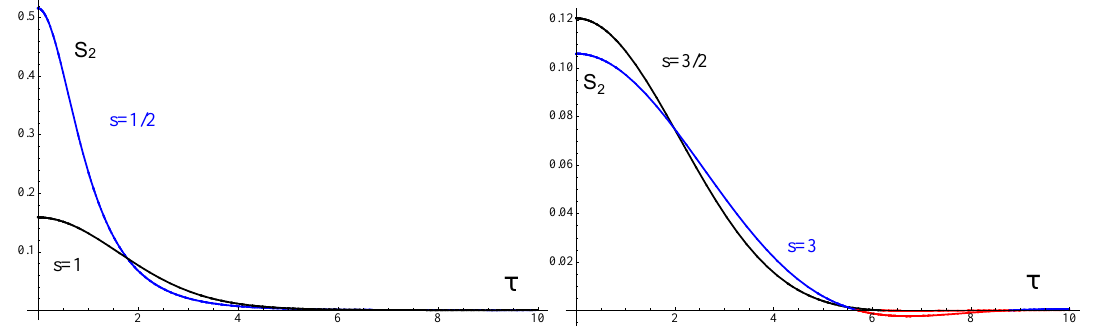
Figure 1. Euclidean time ( τ ) dependence of the (time-reflected) 2-point Schwinger functions S 2 ( − τ , x ; τ , x ) for a non-local scalar field theory with higher derivatives given by Equation (1). For values of s > 1 the S 2 function always reaches negative values for some Euclidean times. The red (blue or black) color indicates the values of Euclidean time τ where negative (positive) values are attained. However S 2 ( − τ , x ; τ , x ) is always a strictly positive function for s (cid:54)